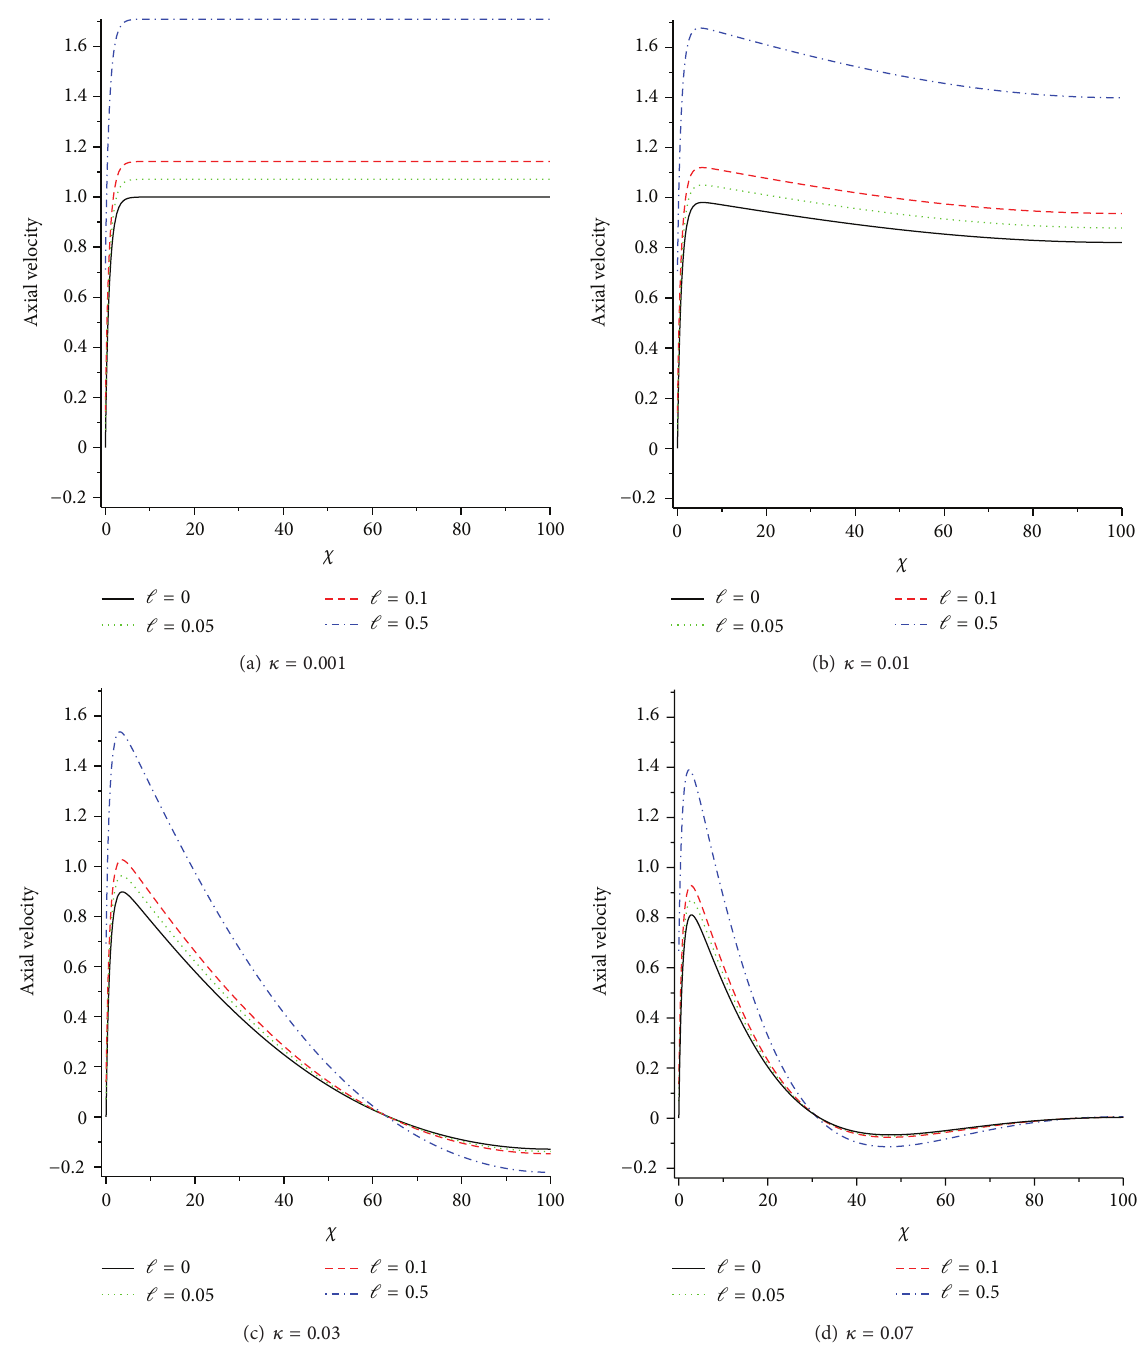
Figure 2: Effect of slip length on velocity profile obtained from the model with 𝜃 = 𝜋/2 , 𝛼 = 1 , and ℎ = 100 𝜆 for various 𝜅 values: (a) 𝜅 = 0.001 ; (b) 𝜅 = 0.01 ; (c) 𝜅 = 0.03 ; (d) 𝜅 = 0.07